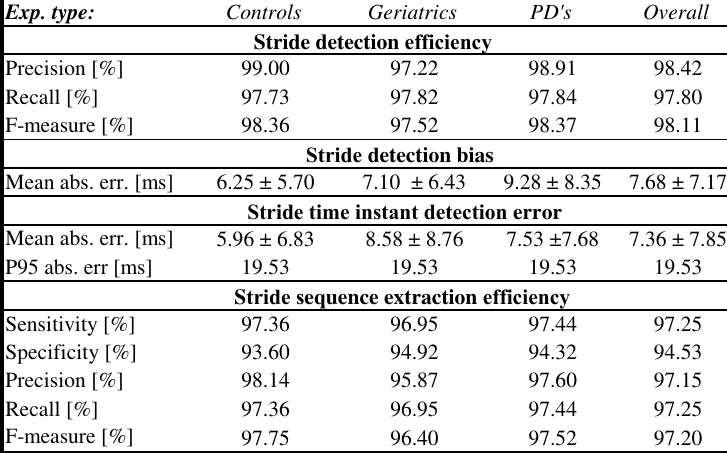
Figure 8. Overall results of the performance of proposed approach on eGait